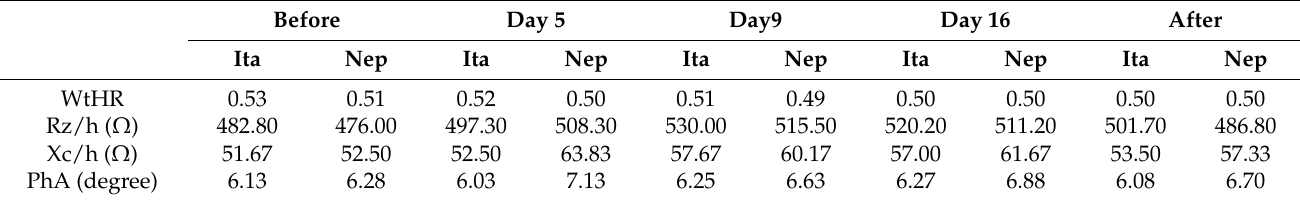
Figure 2. Body mass index (BMI) and Fat-Free Mass Index (FFMI) of participants, before, during (day 5, 9 and 16) and after the altitude expedition. White columns refer to the Italian group, and black columns to the Nepalese group. Data are shown as mean and standard deviation. Table 4. Mean values of anthropometric tests and bioimpedance analysis during the expedition in both group of participants.